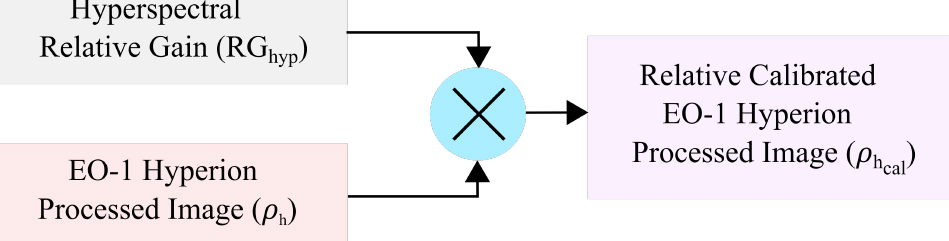
Figure 12. Block diagram showing the relative calibration on the EO-1 Hyperion-processed image.